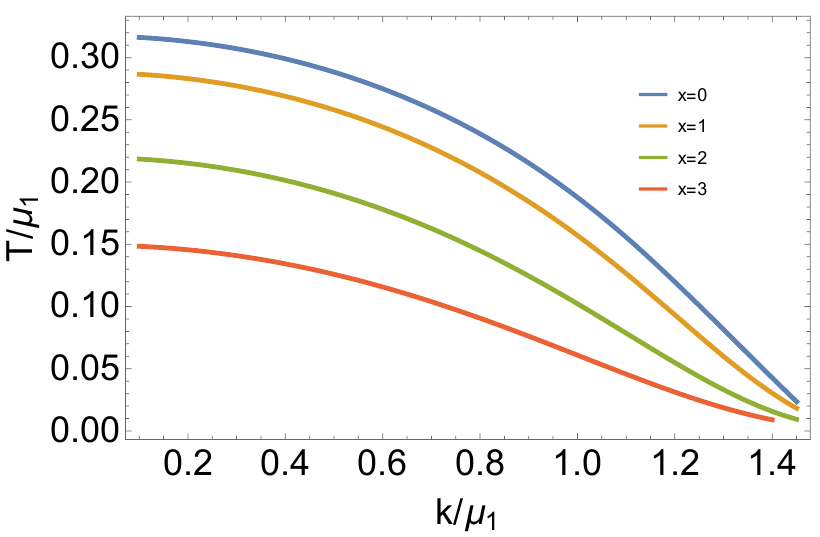
Figure 1 . The critical temperature as the function of wave number for x = 0 , 1 , 2 , 3 . The region below each curve becomes unstable and CDW can be generated.